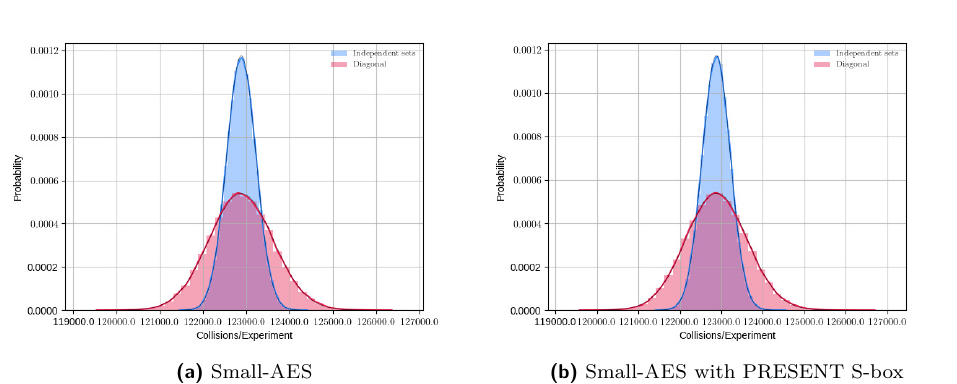
Figure 12: Distribution of the number of collisions in the first byte after five rounds in both settings, with the final MixColumns operation omitted. Both distributions used 100 000 random keys and counted the collisions from 2 14 δ -sets per key that were independent in Setting (1) or the 2 14 δ -sets from D . Thin lines are fitted normal distributions, thick lines the best fitted { 0 } distributions.